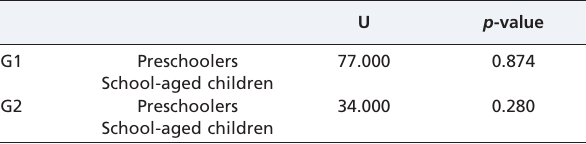
Table 5 - Comparisons by age group of the peak intensity within each CV